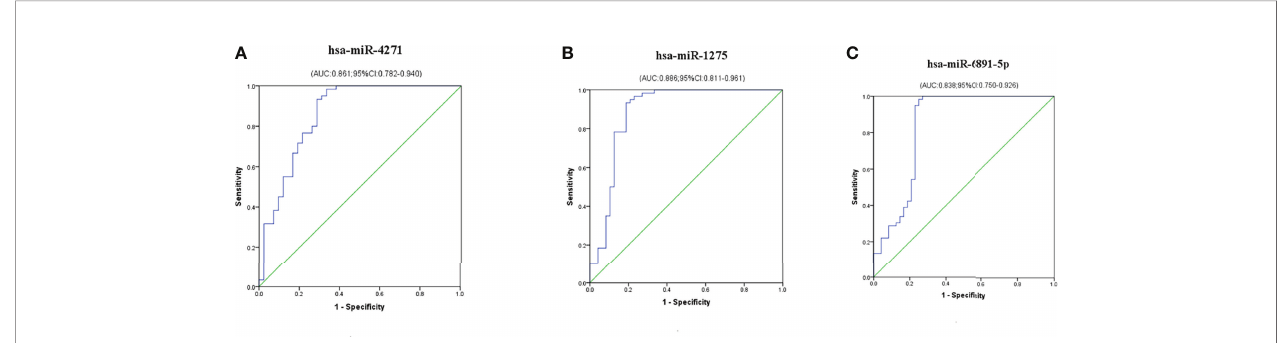
FIGURE 5 | Diagnostic utility of single exosome miRNA levels in maternal serum in pregnant women with ICP. (A) hsa-miR-4271; (B) hsa-miR-1275; (C) hsa-miR- 6891-5p.